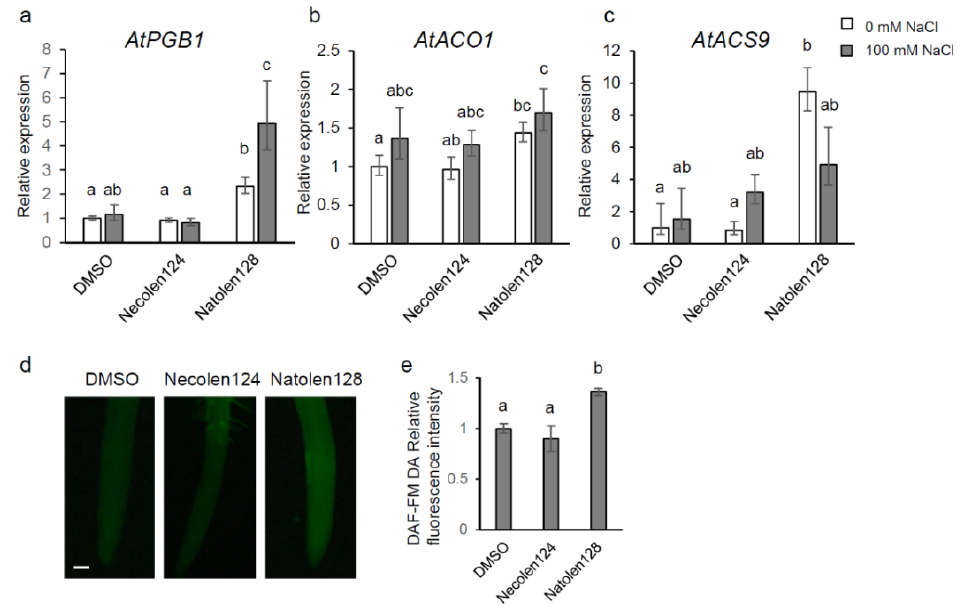
Figure 3. Hypoxia-responsive gene expression and NO changes due to Natolen128 treatment. ( a – c ) Relative expression levels of the AtPGB1 ( a ), AtACO1 ( b ) and AtACS9 ( c ) genes during salinity-stress treatment for 0 and 2 h with or without 2 µM Natolen128 or 2 µM Necolen124. The expression level in plants treated with DMSO was set as 1. 18S rRNA was used as an internal standard. Error bars represent the mean ± SE ( n = 3). Statistical significance was determined by ANOVA, followed by post-hoc Tukey’s tests. Means that differed significantly ( p < 0.05) are indicated by different letters. ( d ) NO detected with DAF-FM DA in Arabidopsis roots treated with 2 µM Natolen128 or Necolen124 for 6 h. Plants treated with DMSO for 6 h were used as negative controls. Scale bar = 50 µm. ( e ) Relative fluorescence intensity of DAF-FM DA in roots treated with 2 µM Natolen128 or 2 µM Necolen124. The fluorescence intensity in plants treated with DMSO was set as 1. Statistical significance was determined by ANOVA, followed by post-hoc Tukey’s tests. Means that differed significantly ( p < 0.05) are indicated by different letters.